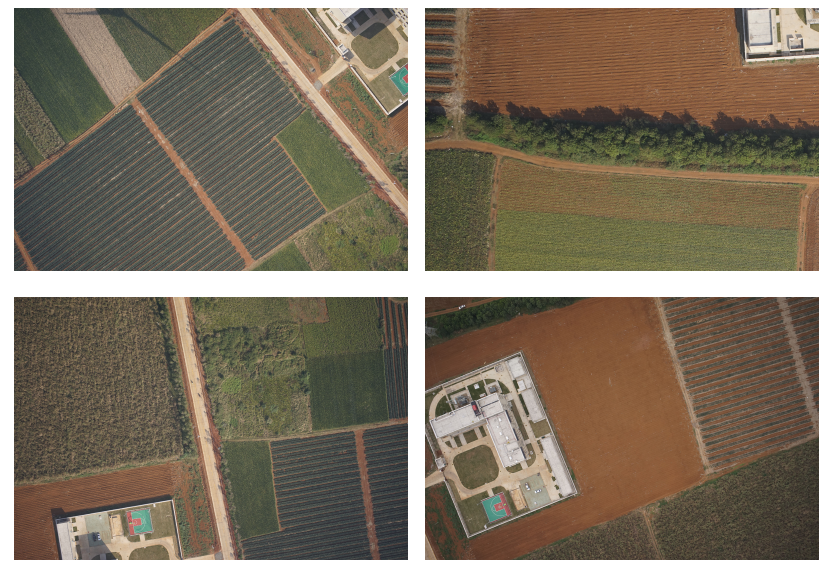
Figure 9. Some of the aerial images were used to generate the digital orthophoto of farmland with a factory